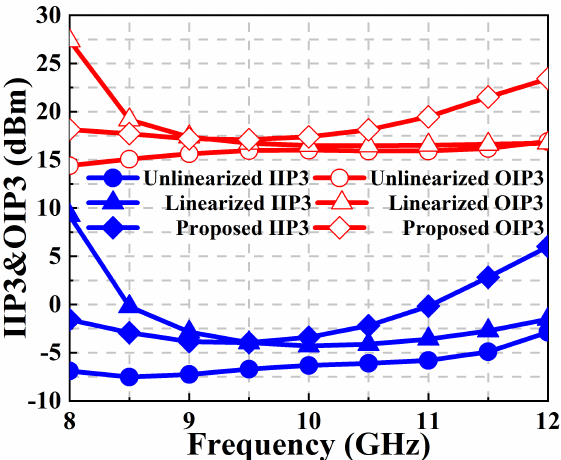
Figure 16. Simulated IIP3 and OIP3 based on the nonlinearized, conventional linearized post- distortion, and proposed post-distortion topology.